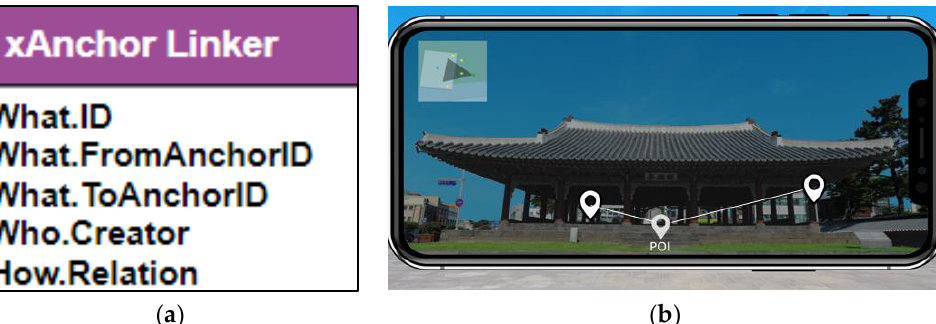
Figure 3. The xAnchor linker metadata: ( a ) attributes of the xAnchor linker and ( b ) an example of implementation using the xAnchor linker.